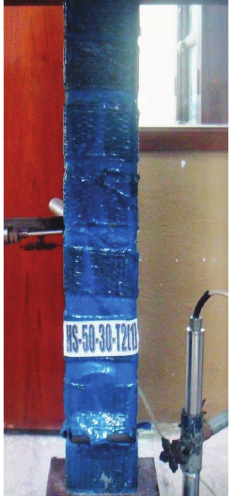
Figure 9: Failure mode of column HS-50-30-T2 (1)